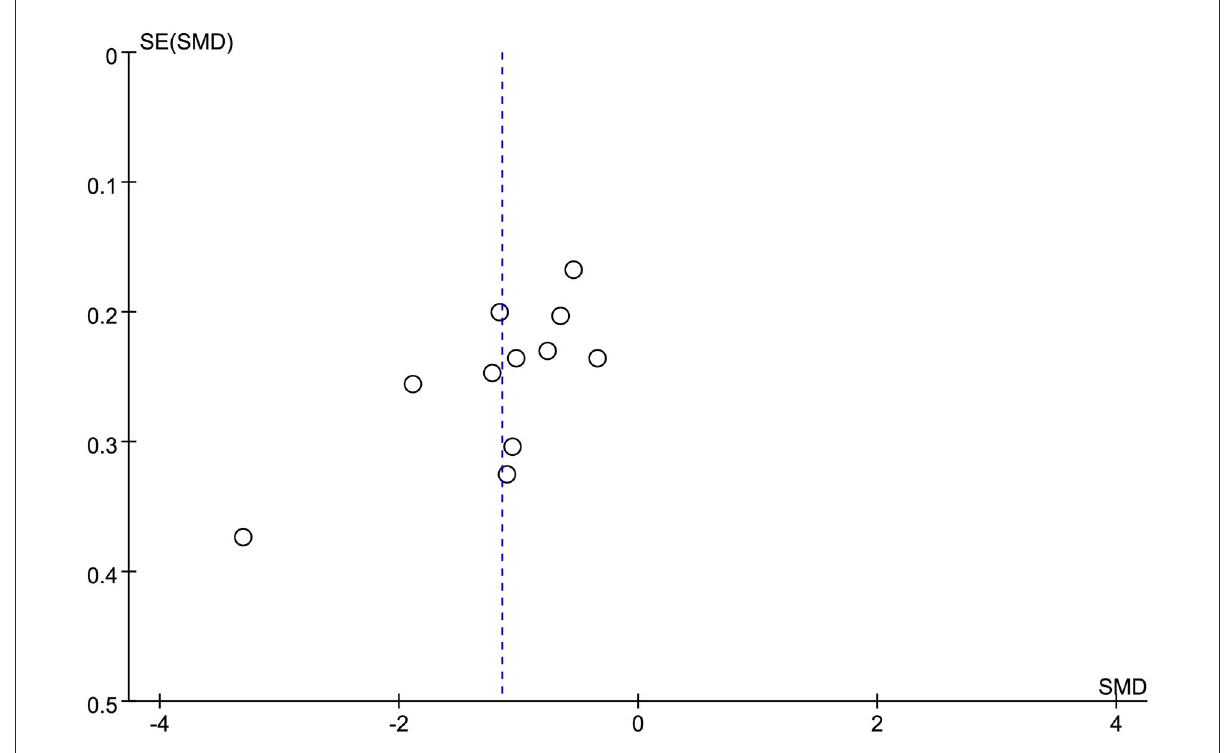
FIGURE10 HAMD changes the value of published bias funnel